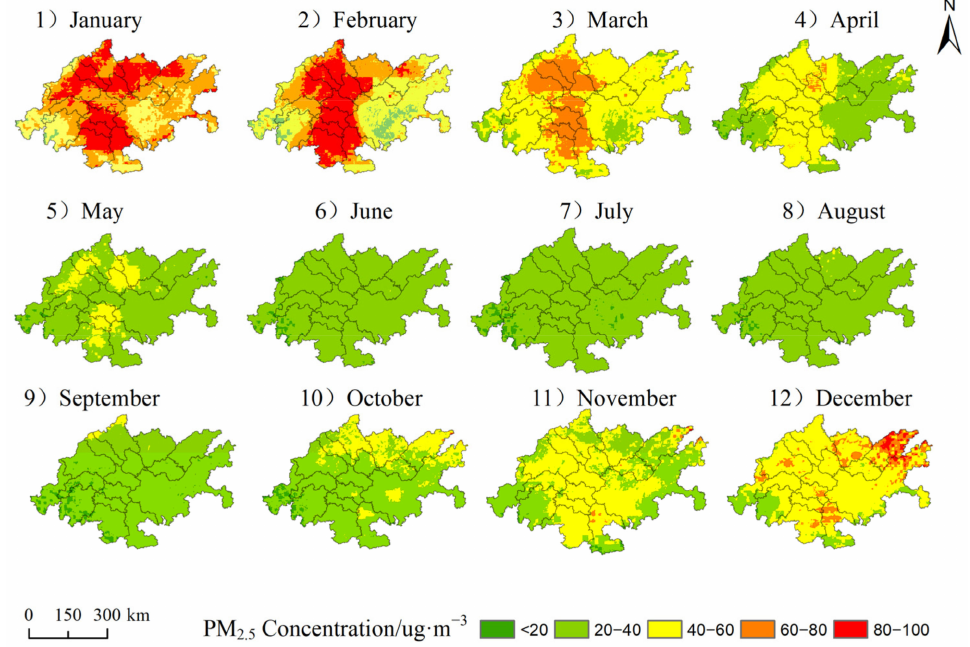
Figure 5. Distribution of PM 2.5 in Chengdu